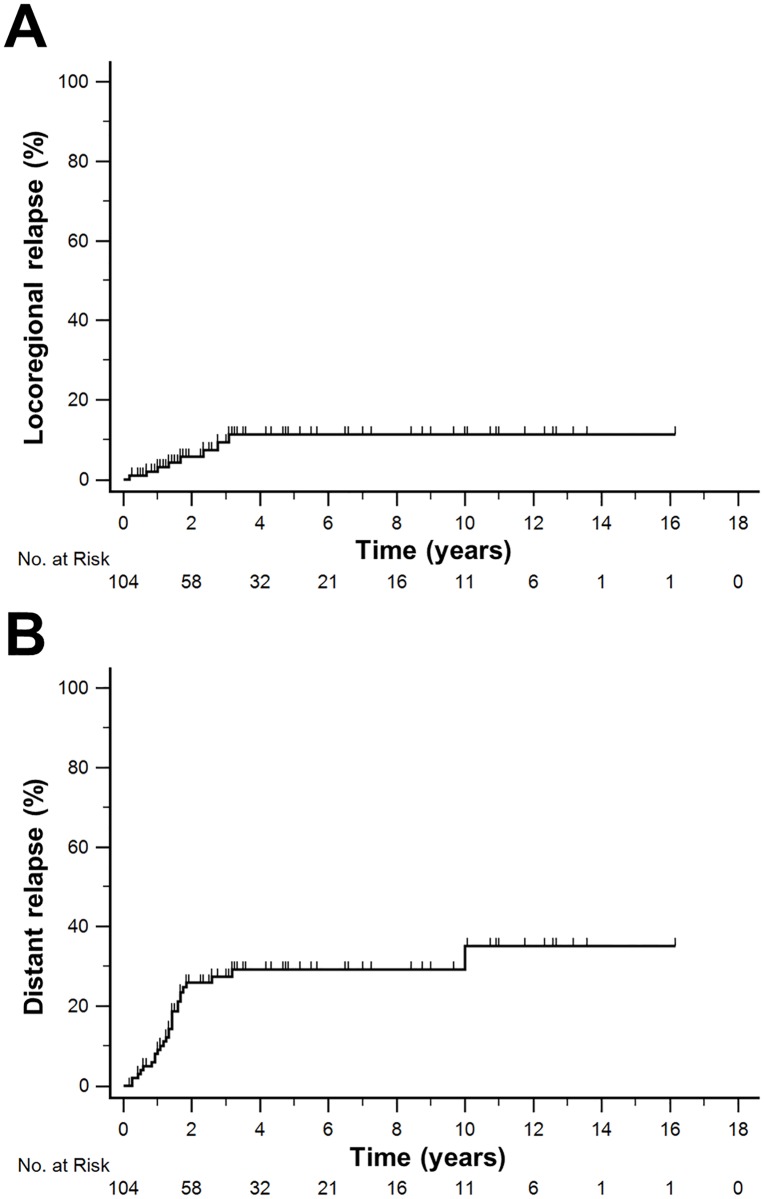
Risk of relapse.(A) Cumulative risk of locoregional relapse: 5.7% (95% CI, 0.7–10.7%) at 2 years and 11.3% (95% CI, 3.5–19.1%) at 5 years. (B) Cumulative risk of distant relapse: 25.9% (95% CI, 16.7–35.1%) at 2 years and 29.2% (95% CI, 19.4–39.0%) at 5 years.